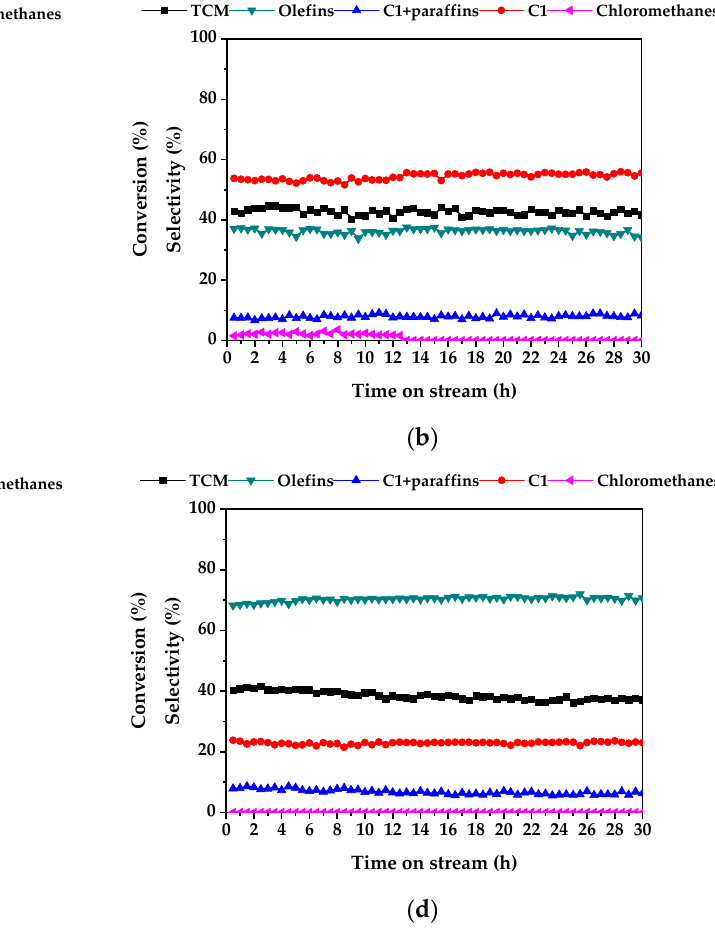
Figure 7. Stability of catalysts during the HDC of TCM: ( a ) Pd/CNF, ( b ) Pd/CNF-Cl, ( c ) Pd/CNF-N, ( d ) Pd/CNF-U (T reaction = 250 ° C; τ = 0.2 kg h mol − 1 ; H 2 /TCM = 50).